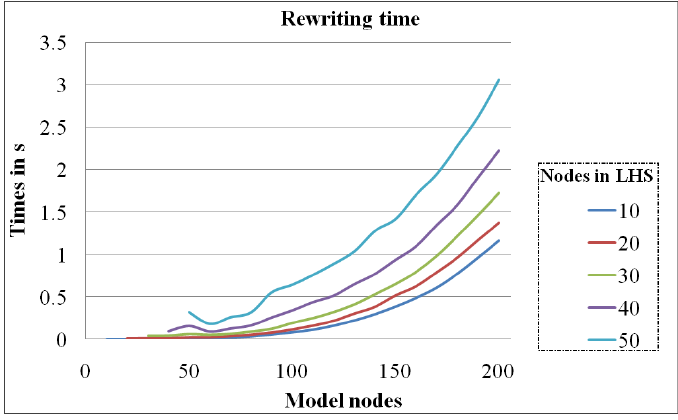
Figure 13. Correlation between the model size and the GRR